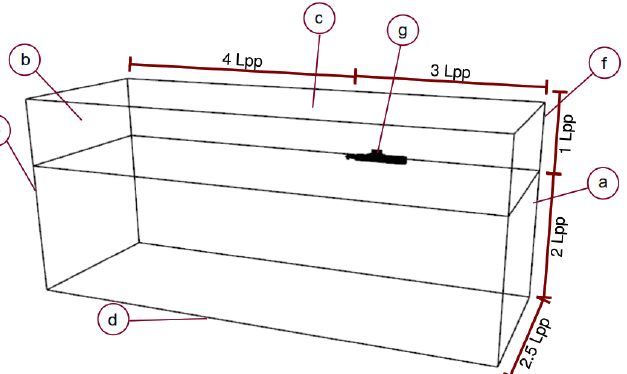
Figure 4. Computational domain and boundaries used to model DARPA SUBOFF and Type 209/1300 submarines.